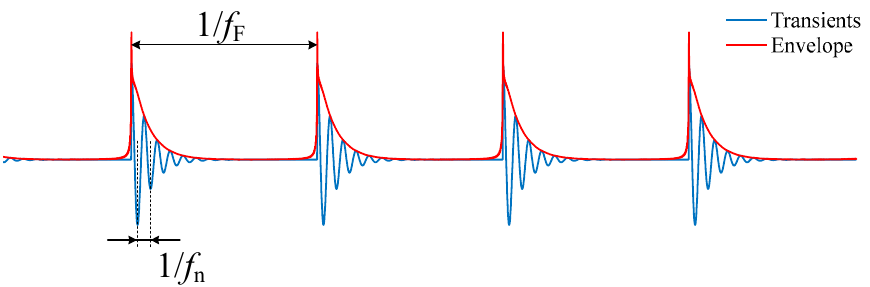
Figure 1. Transient response of bearing defects.